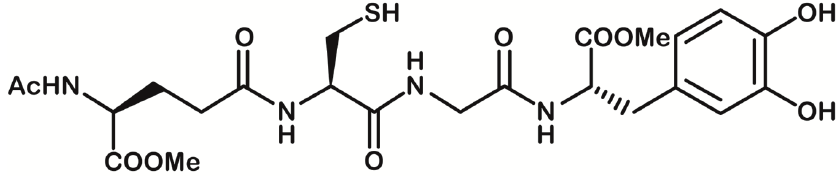
Figure 1. Chemical structure of glutathione-L-3,4-dihydroxyphenylalanine (GSH-LD) codrug.